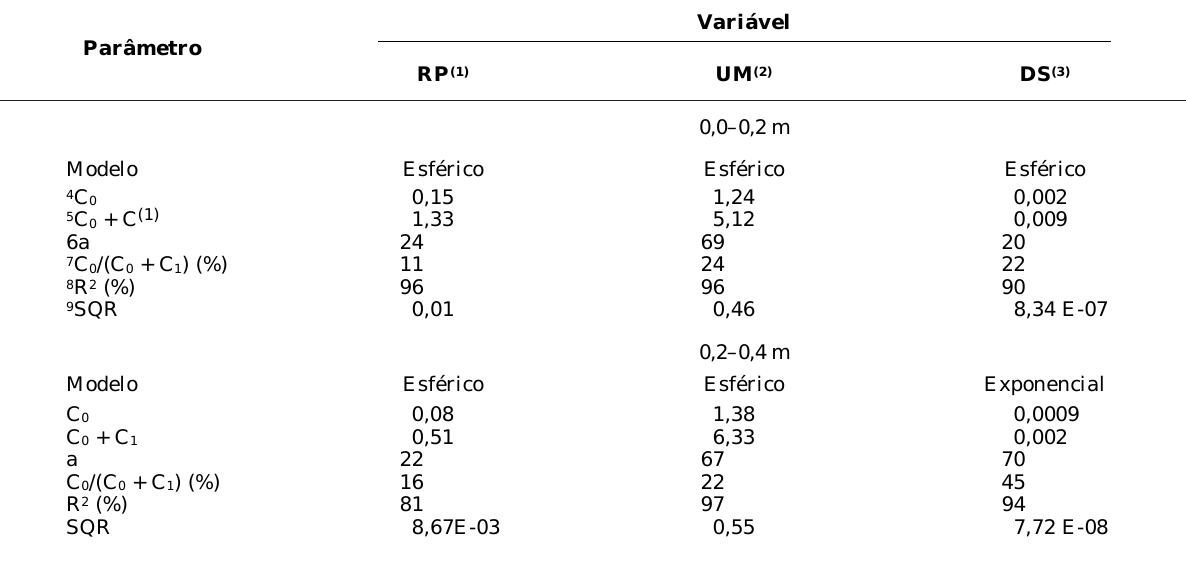
+C = patamar. (6) a 0 1